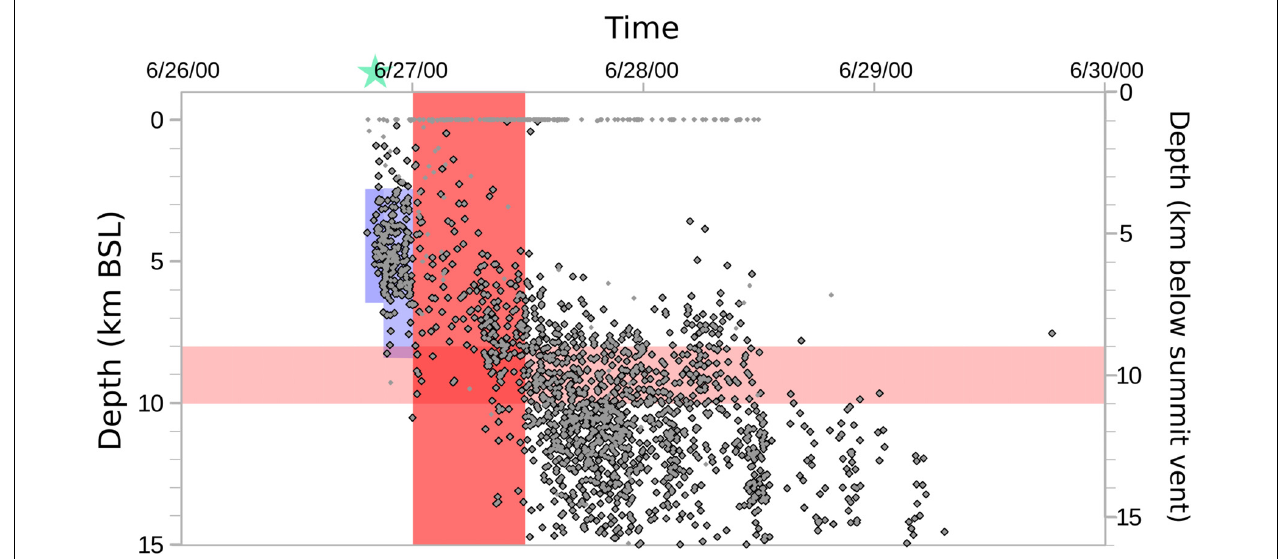
FIGURE 8 | Time-depth plot for Miyake-jima Volcano, Japan, in late June 2000. Light red – petrologically-defined magma source. Dark red – eruptions. Light blue shading shows the timing and depth of precursory seismicity. Gray dots show all earthquakes and black outlined dots show earthquakes with well-constrained locations. Green star indicates onset of GPS-detected